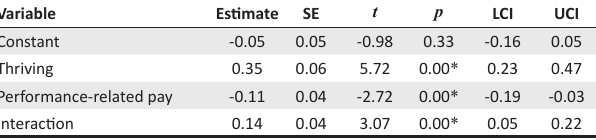
TABLE 4: Regression results for the moderation effect.